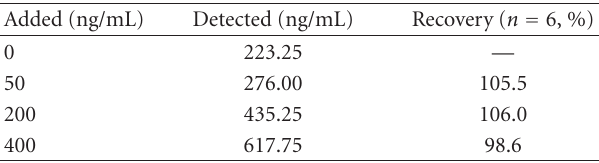
Figure 3: Chromatograms of urine sample (total ion) diluted with water and methanol. Table 1: Recovery of the method with dilution of urine samples (2000-fold).